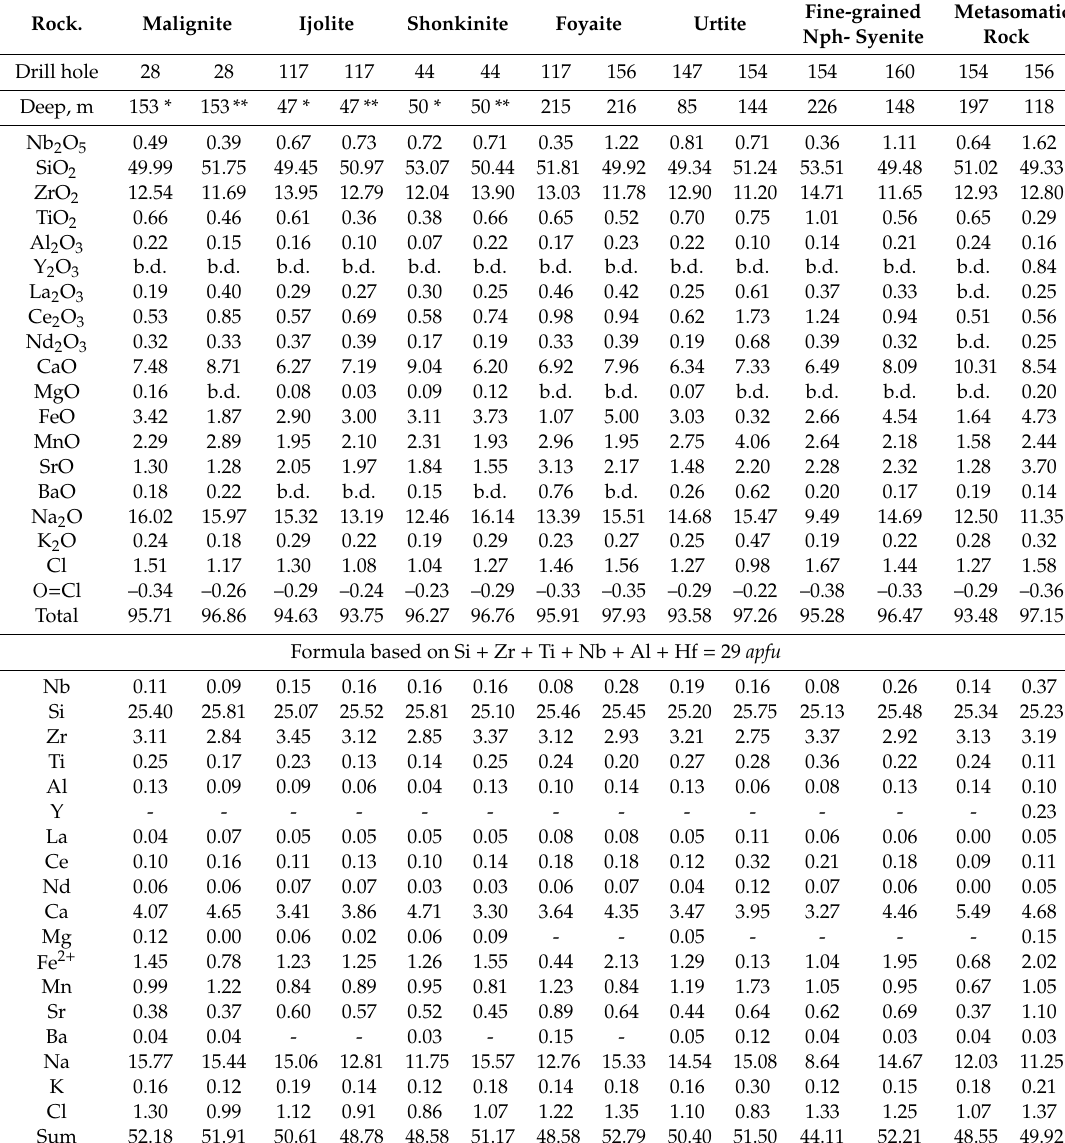
Table 5. Representative microprobe analyses of EGM, wt.